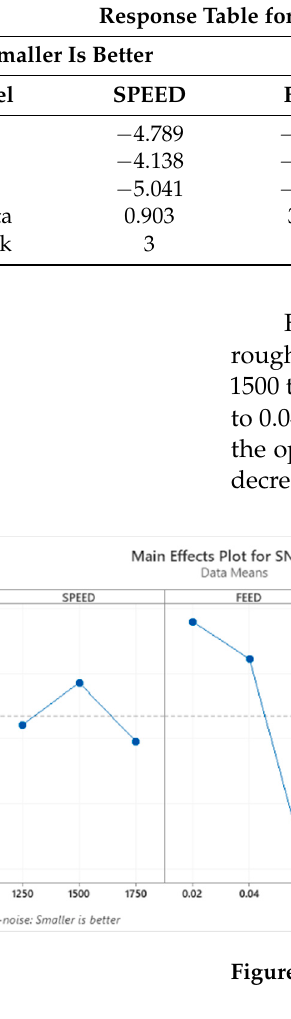
Table 11. Response table for Ra.